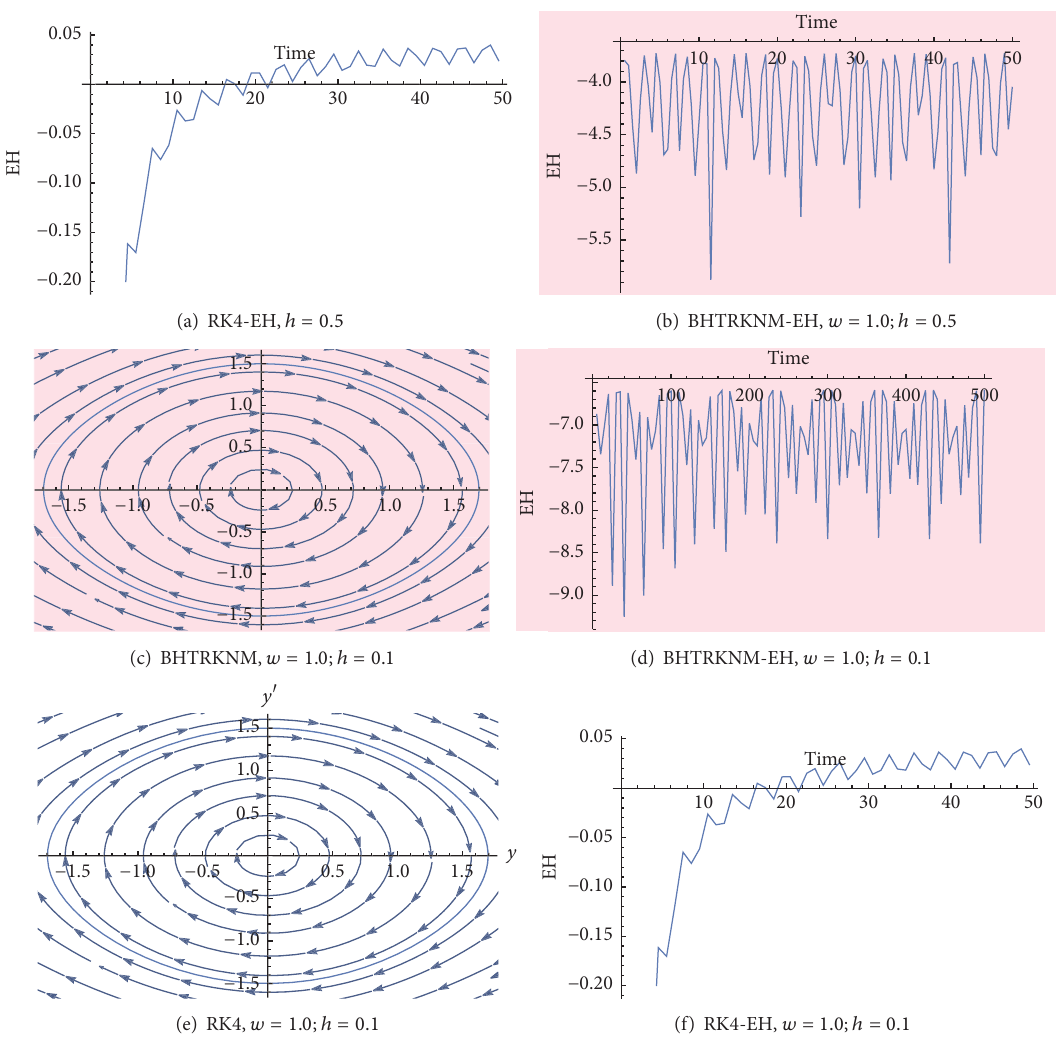
Figure 9: The pendulum problem: Hamiltonian error EH = |𝐻 𝑛 − 𝐻 0 | using RK4 with ℎ = 0.5 is presented in (a), while (b) shows EH for BHTRKNM. We also solve the problem on a larger interval of integration [0,500] , using the BHTRNM in (c) and (d) and the RK4 in (e) and (f),